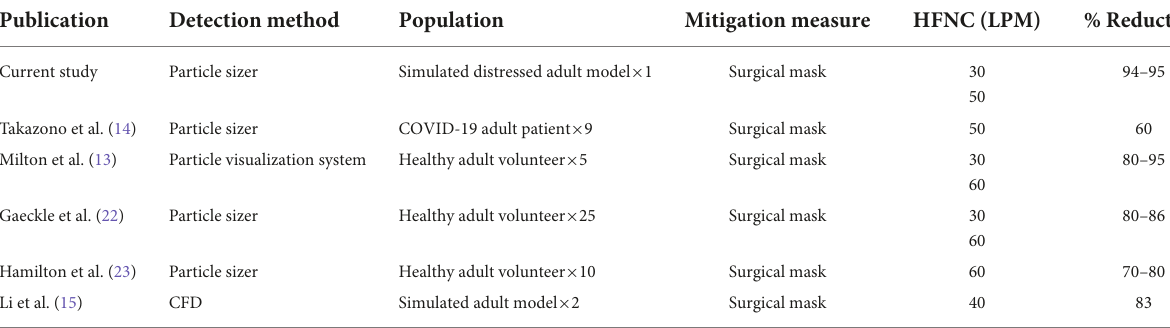
TABLE 3 Comparison of average % reduction in aerosol dispersion using a mitigation measure during